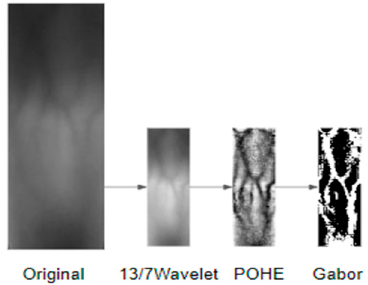
Figure 3. Image pre-processing and feature extraction.